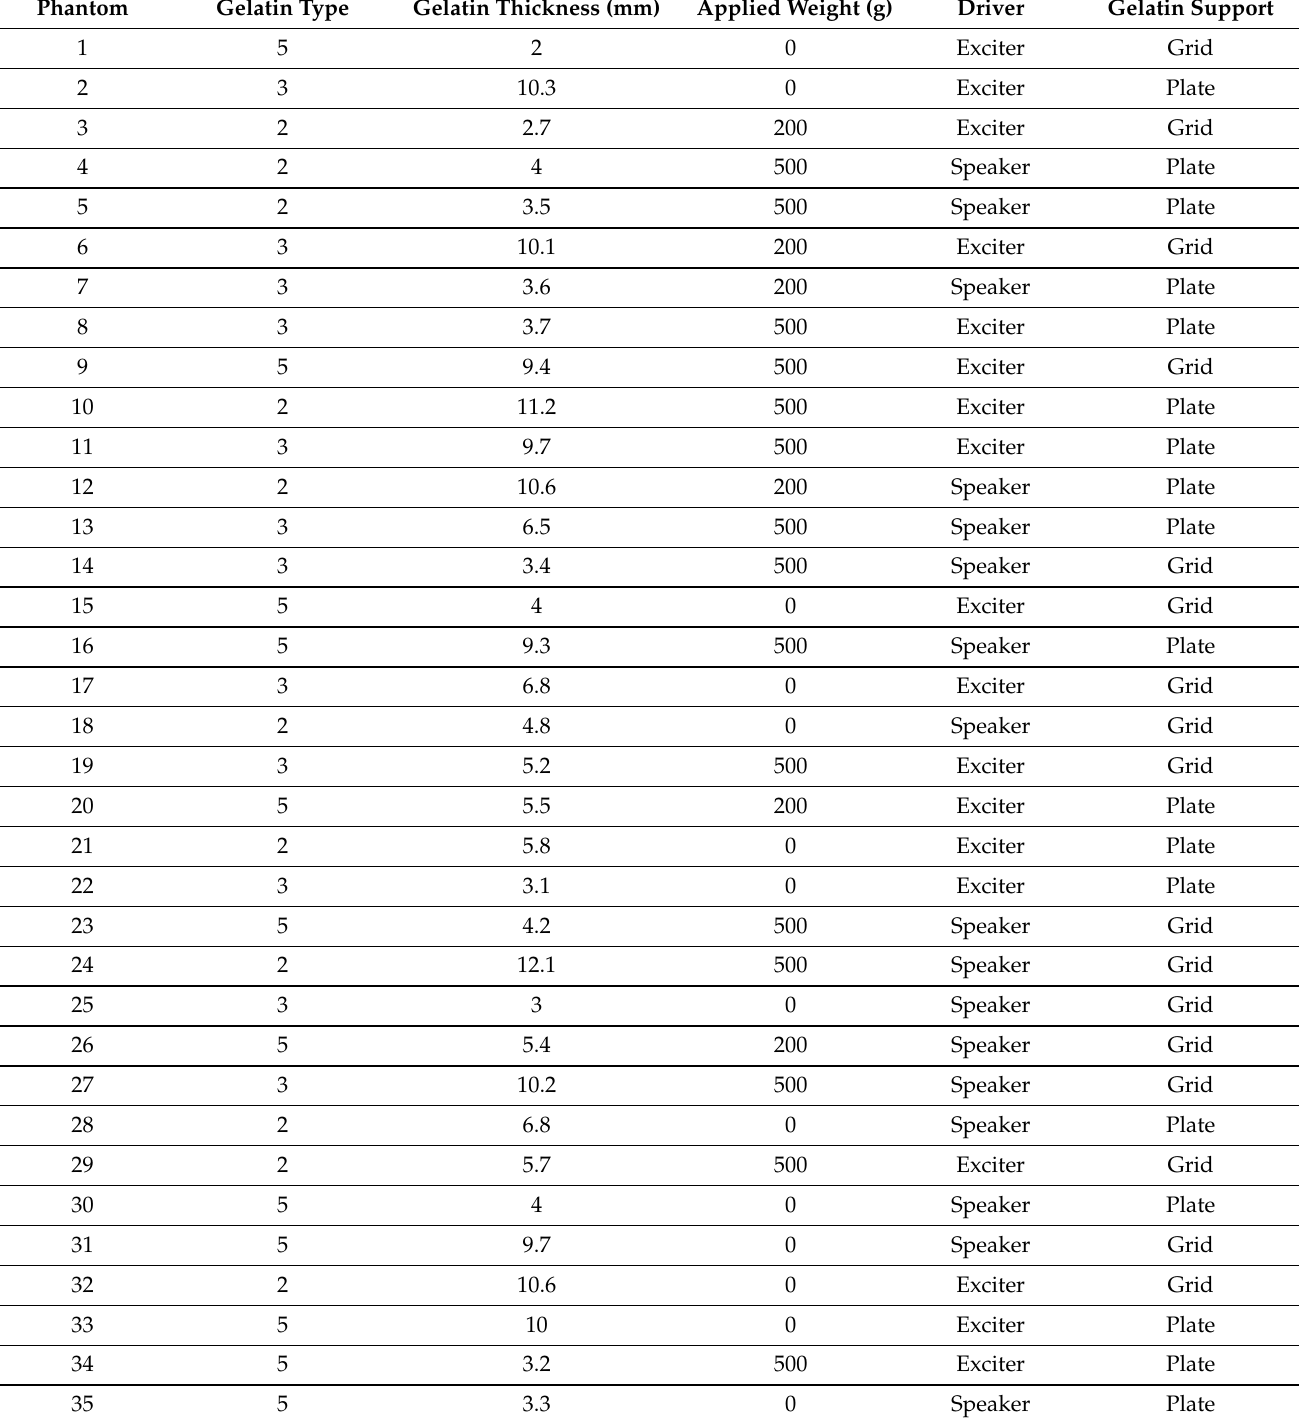
Table 2. The acoustic phantom treatments measured for the design of